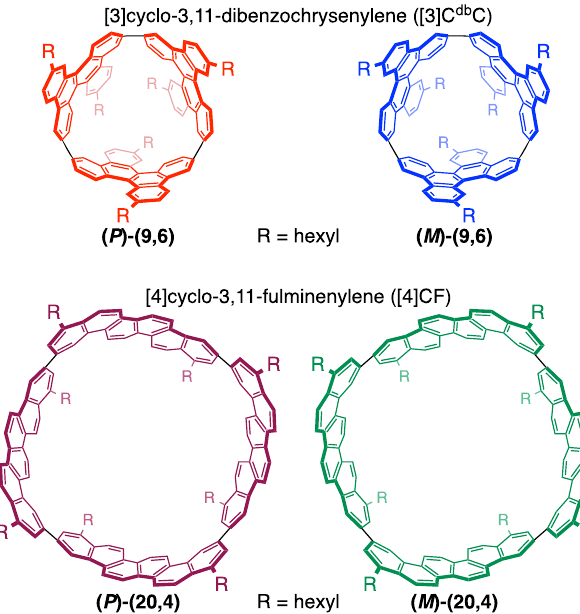
Fig. 2 Helical CNT molecules. Chemical structures of small-bore [3]C db C molecules and large-bore [4]CF